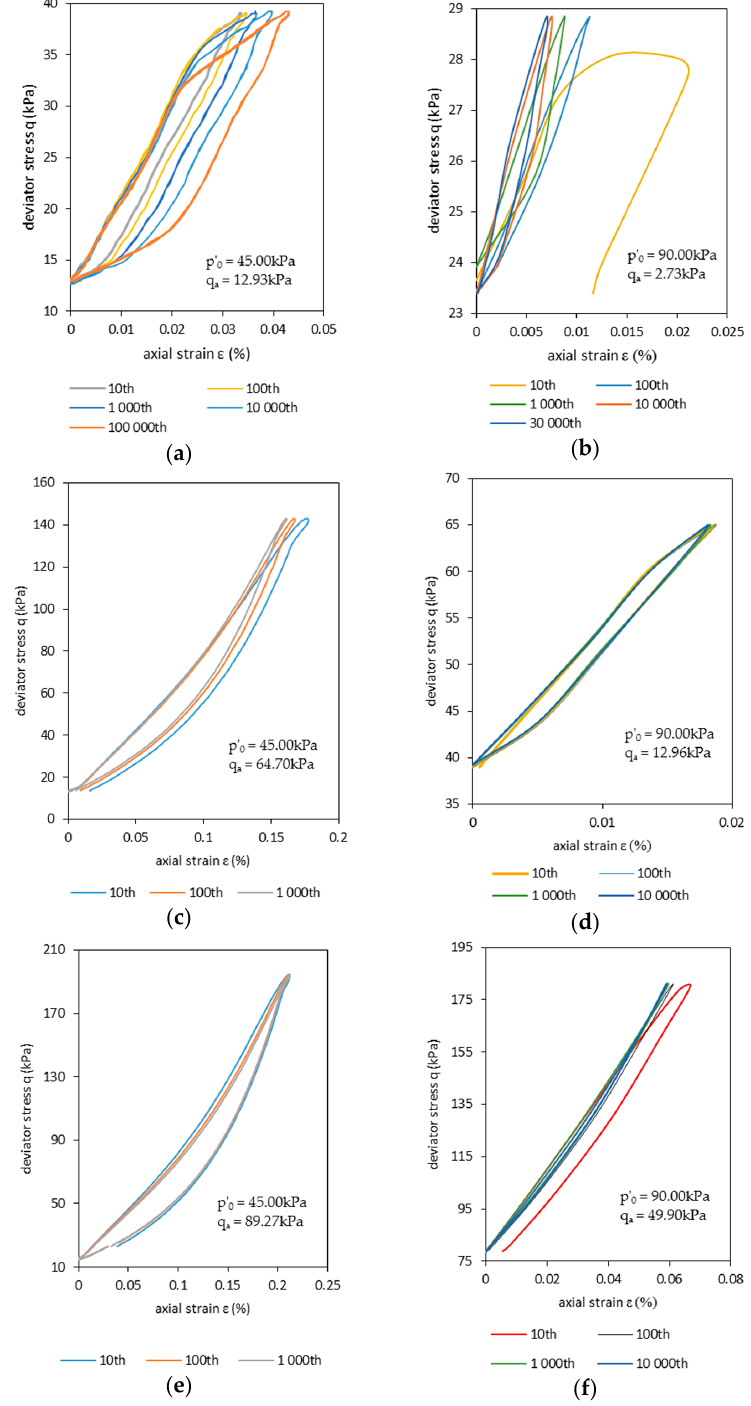
Figure 10. Stress-strain plot during three test levels on an RCA sample under different effective stresses p’ 0 , as indicated in the figures (different lines correspond to different loading cycles). The panels correspond to: ( a ) Test 1.1; ( b ) Test 2.1; ( c ) 1.2; ( d ) Test 2.2; ( e ) Test 1.3; ( f ) Test 2.3.